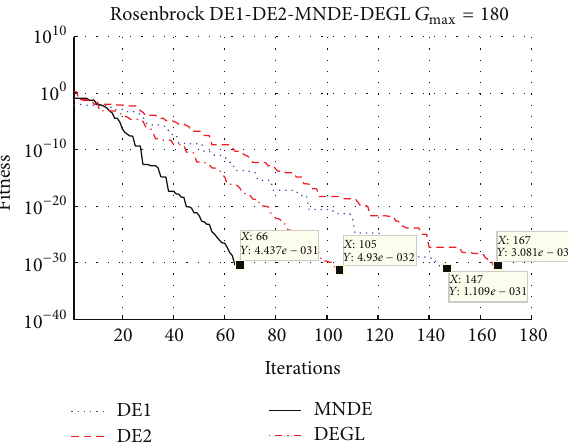
Figure 3: The evolution results for Rosenbrock function with the same predefined